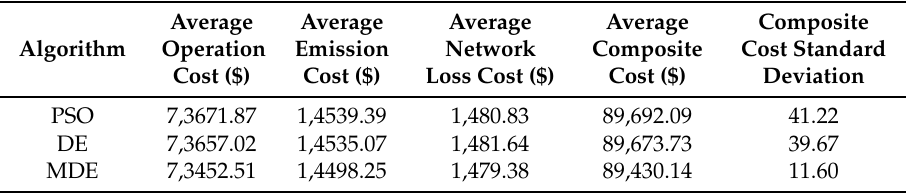
Table 5. Statistical result of different